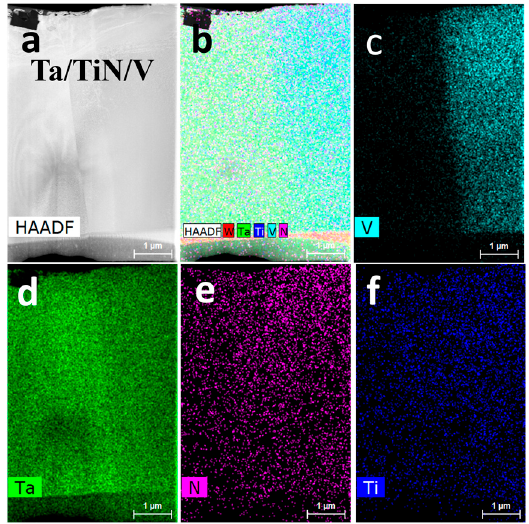
Figure 18. W/V/TiN/Ta-laminated composite joined at 1400 °C: ( a ) HAADF image; EDS mapping pro fi le of ( b ) W, Ta, Ti, N, V, ( c ) V, ( d ) Ta, ( e ) N, ( f ) Ti.